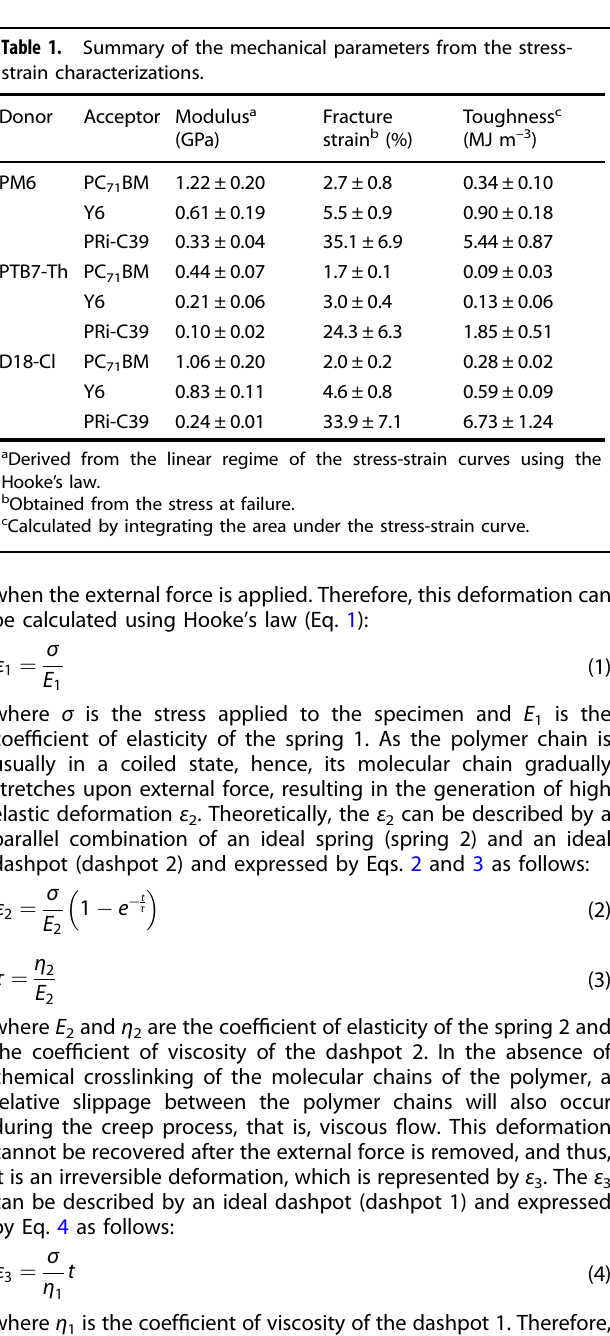
Table 1. Summary of the mechanical parameters from the stress- strain characterizations.